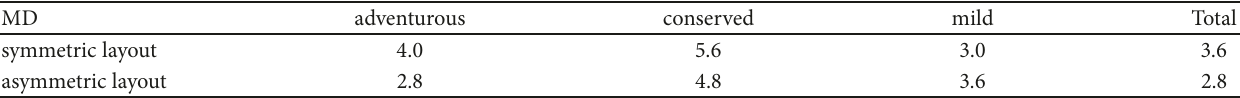
Figure 13: Four simulation cases with different choice preferences under symmetric layout (left) and asymmetric layout (right). Table 3: The values of MD for different